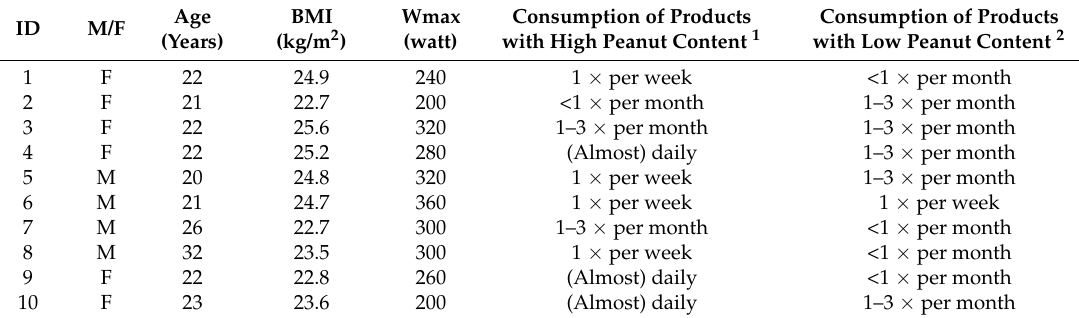
Table 1. Subject